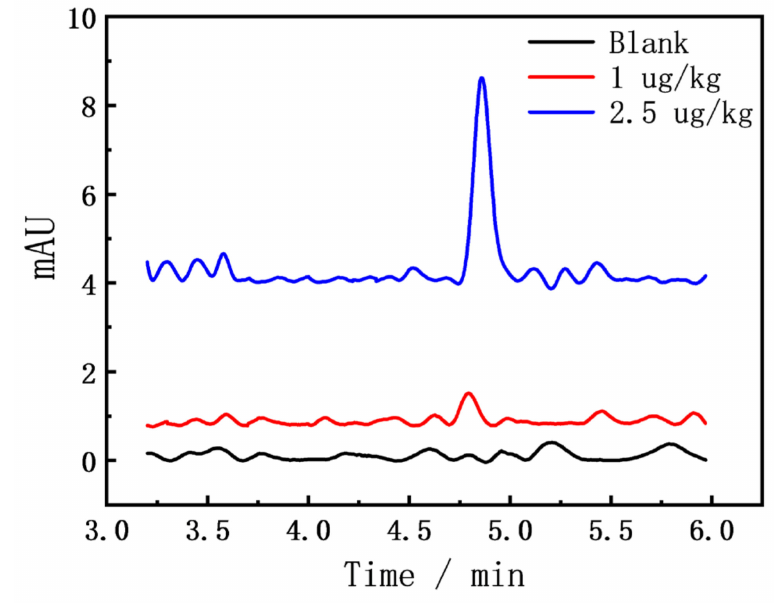
Figure 3. HPLC chromatogram of the FZD in sediments.